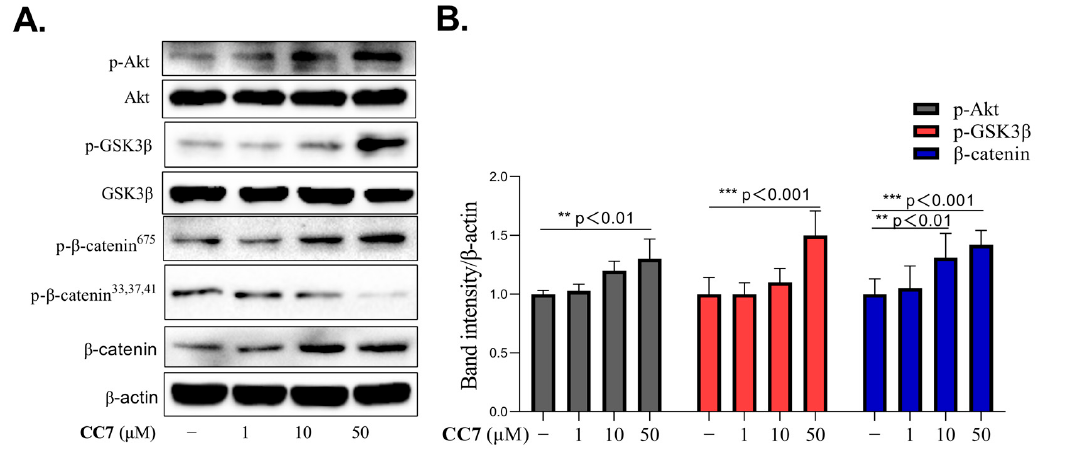
Figure 6. The effects of CC7 on Akt/GSK3 β / β -catenin signal pathway in B16 cells. ( A ) Western blotting results of protein levels of p -Akt, p-GSK3 β , p- β -catenin, and β -catenin in B16 cells treated with CC7 at different concentrations (1, 10, and 50 µ M) for 48 h. All proteins were analyzed relative to β -actin expression. ( B ) The quantification of western bands and results are presented as the mean ± SD from three independent measurements using Image J software. ** p < 0.01, *** p < 0.001 compared with NC (negative control) group.